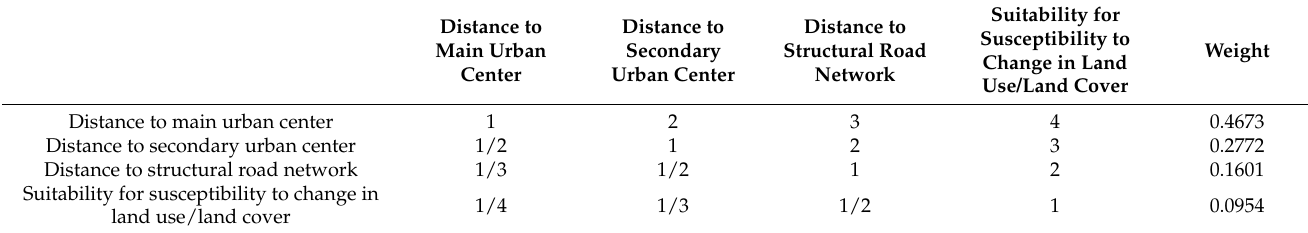
Table 6. Paired comparison matrix for determining weights for the MCE of the urban suitability objective. Source: Authors’ compilation.